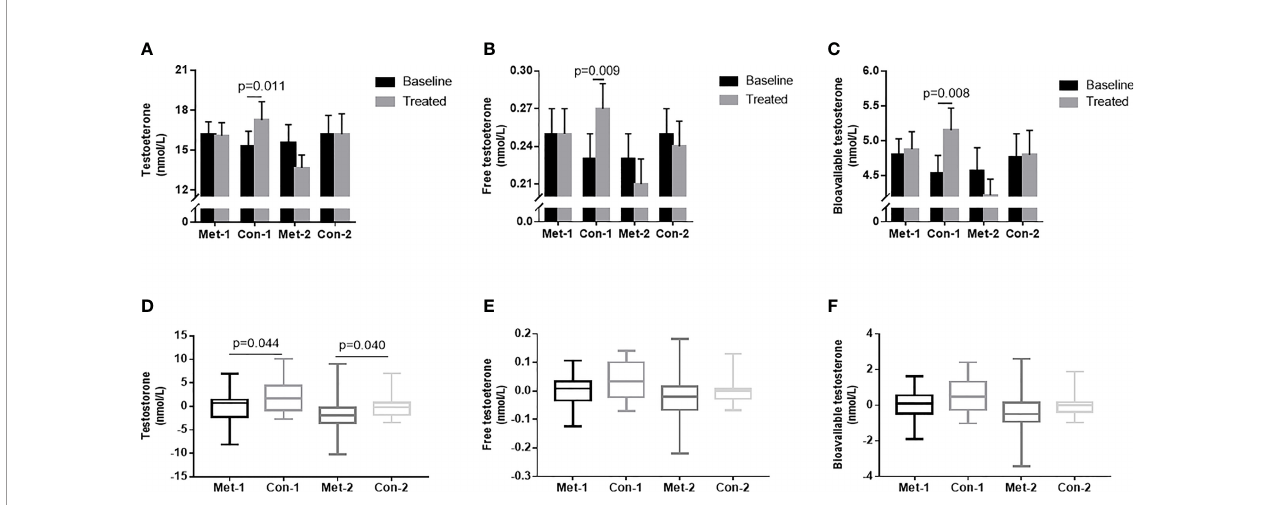
FIGURE 3 | (A – C) TT, FT and Bio-T levels at baseline and endpoint in metformin and control groups under different strati fi cation. (D – F) the changes of TT, FT and Bio-T levels between metformin and control group before and after treatment under different strati fi cation. 1= △ GA ≤ 0; 2 = △ GA>0; Data are mean ±